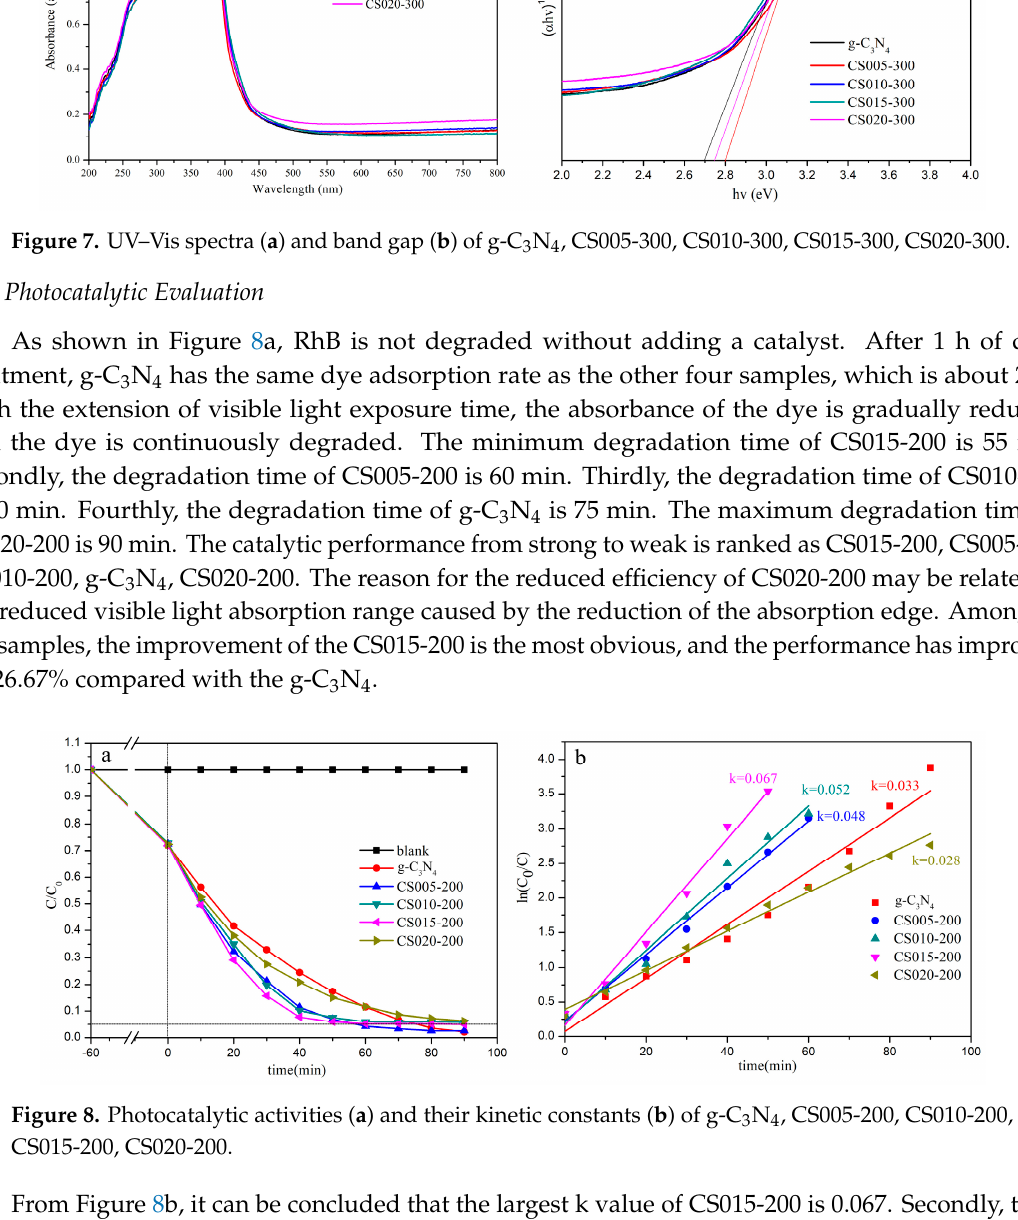
Figure 7. UV–Vis spectra ( a ) and band gap ( b ) of g-C 3 N 4 , CS005-300, CS010-300, CS015-300, CS020- 300.